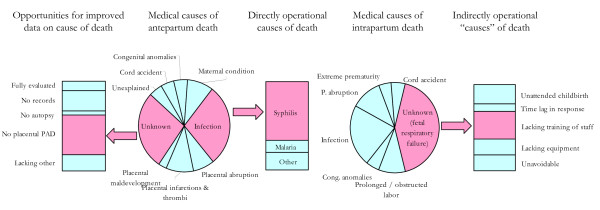
Operational causes of death. Examples of causes of antepartum and intrapartum deaths that may be targeted directly for stillbirth prevention (e.g., syphilis) or indirectly to improve clinical quality of care or ability to capture data for further improvement. PAD: pathological-anatomical diagnosis.